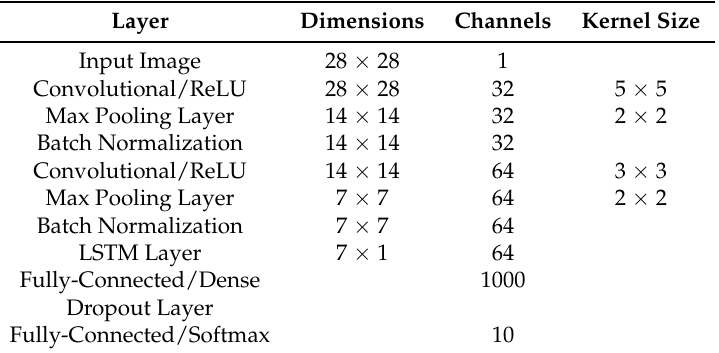
Table 2. Abbreviations for different methods